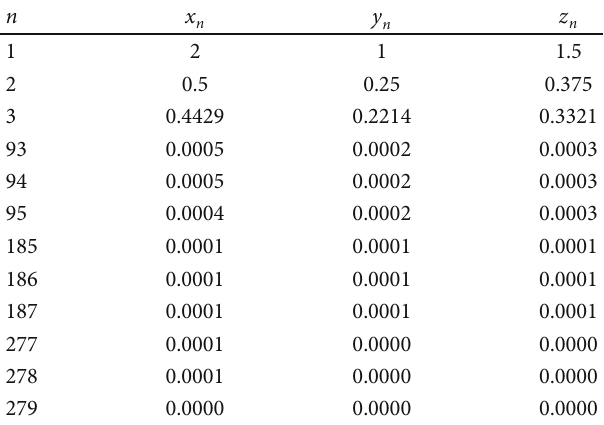
Table 1: Numerical results of convergence for x